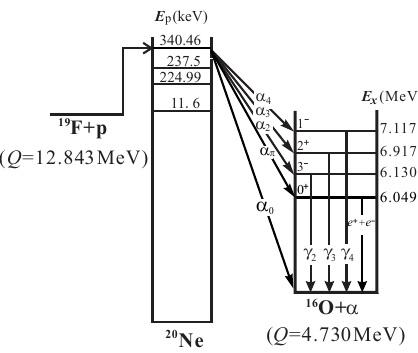
Figure 1. Level scheme of the 19 F( p , α ) 16 O reaction. The total reaction rate is dominated by the ( p , α 0 ) and ( p , αγ )